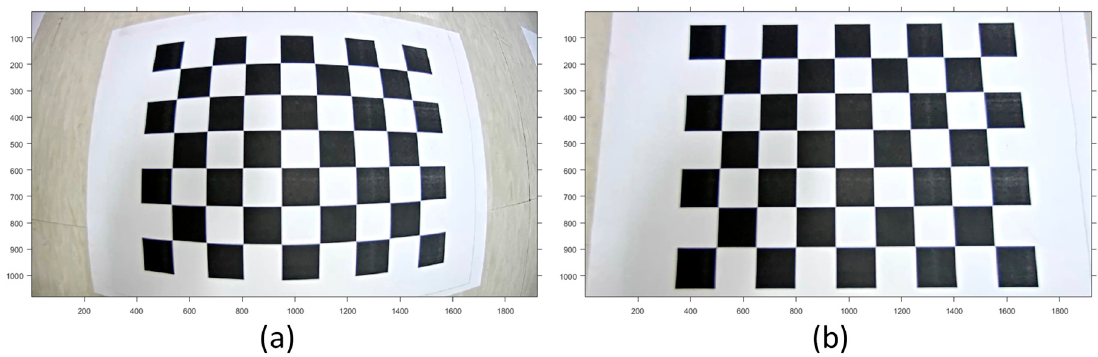
Figure 11. Result of image rectification with calibrated IOPs: ( a ) original image; ( b ) rectified image.